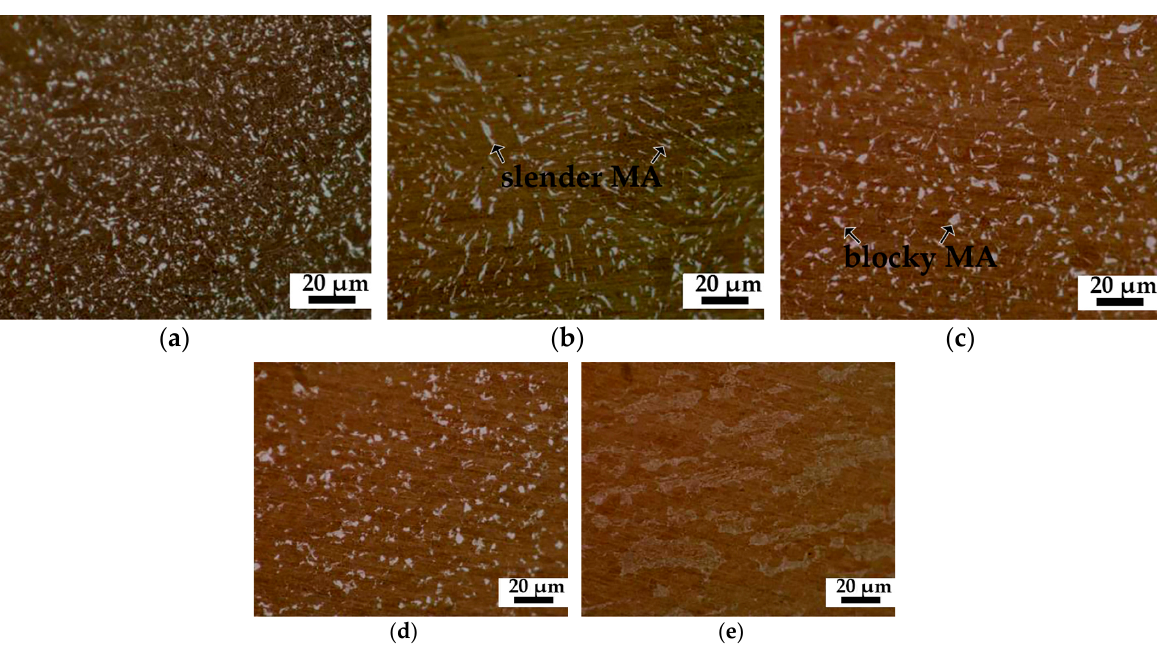
( f ) Figure 4. SEM images of the welded joint. ( a ) FL; ( b ) FGHAZ; ( c ) ICHAZ; ( d ) SCHAZ; ( e ) weld center at 2 mm away from the outside weld surface; ( f ) weld center in midthickness. The FL zone mainly consists of two distinct microstructures, namely intragranular acicular ferrite (IAF) in WM and coarse BF in CGHAZ, resulting in stress concentration in the FL, which has the lowest Charpy impact performance (Figure 4a). The microstructures of the FGHAZ primarily consist of fine GB and PF, which present a good combination of both high strength and toughness (Figure 4b). The ICHAZ, which includes fine GB and PF, as well as MA, is a partially-transformed region with a peak temperature between Ac 1 and Ac 3 , where only a portion of the micro- structure transforms into austenite again during heating thermal cycles, and grains of the untransformed region continue to coarsen and grow. As a result, the grain size distribu- tion in ICHAZ is nonuniform, and banded microstructures (GB bands) are observed in ICHAZ, which would further deteriorate the Charpy impact properties (Figure 4c). As shown in Figure 4d, the microstructure of SCHAZ primarily consists of PF and GB. The microstructures of WM primarily include IAF, a small amount of widmanstatten ferrite (WF) and GB, where PF is also occasionally presented in the weld root in the mid- thickness. Ti-containing complex oxide inclusions in the WM promote the formation of IAF with a radial distribution [17]. Research indicates that the IAF is generally associated with high strength and toughness because of the interlocked and fine-grained structures [18,19]. However, the Charpy impact properties would deteriorate when PF and WF mi- crostructures appear [5,18,20]. Therefore, the values of Charpy impact energy at the weld center near the outer surface are much higher than those of the weld root in the midthick- ness with higher volume fractions of PF and WF (Figure 4e,f) [21].